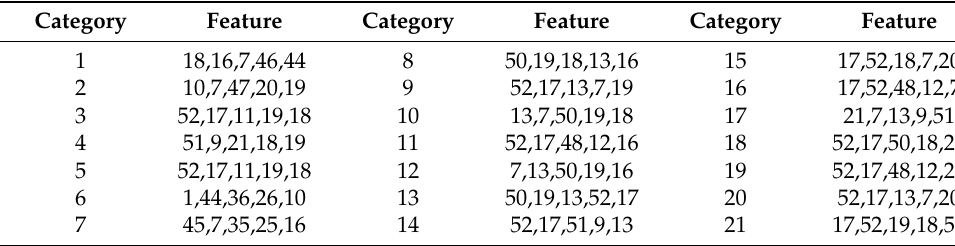
Table 3. Feature selection results of SVM-RFE.